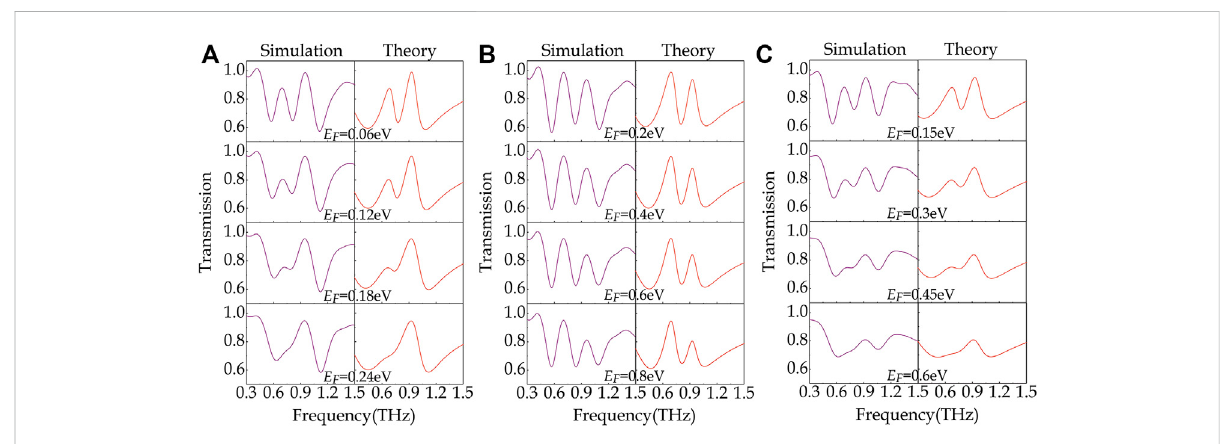
FIGURE 6 Simulated(leftcolumn)andcalculated(rightcolumn)amplitudetransmissionspectraof (A) D-EIT-g1, (B) D-EIT-g2, (C) D-EIT-g12atvarious E F